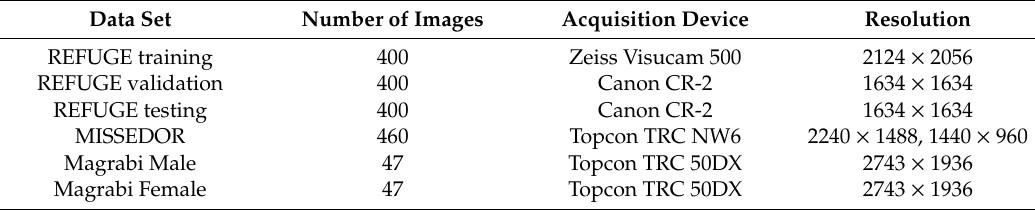
Table 1. Datasets used in training and testing.